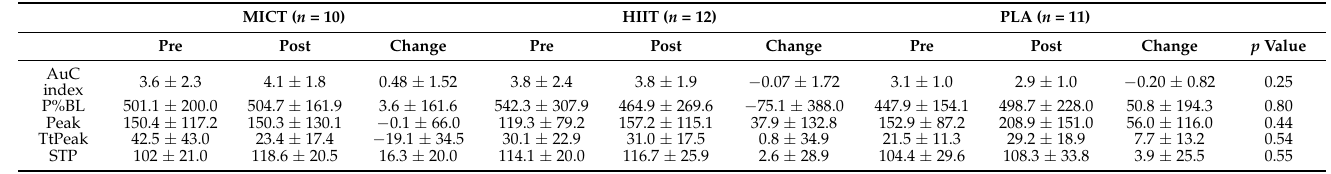
Table 2. Group mean change scores for primary and secondary